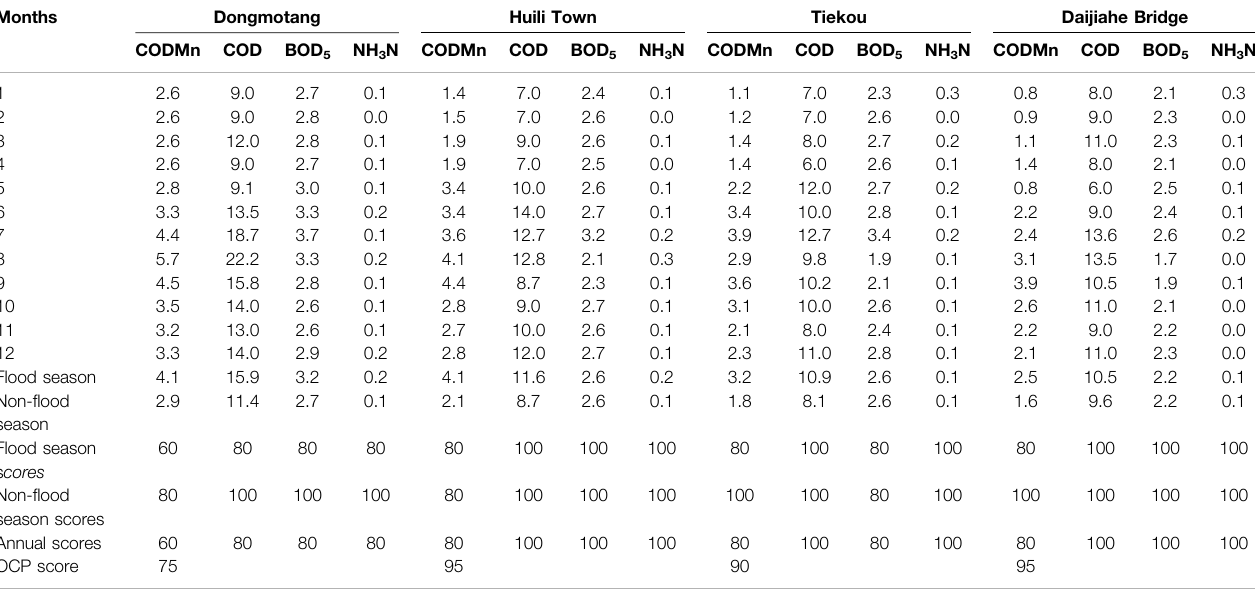
TABLE 8 | Results of organic oxygen consumption pollutants (mg/L) and grading. Months